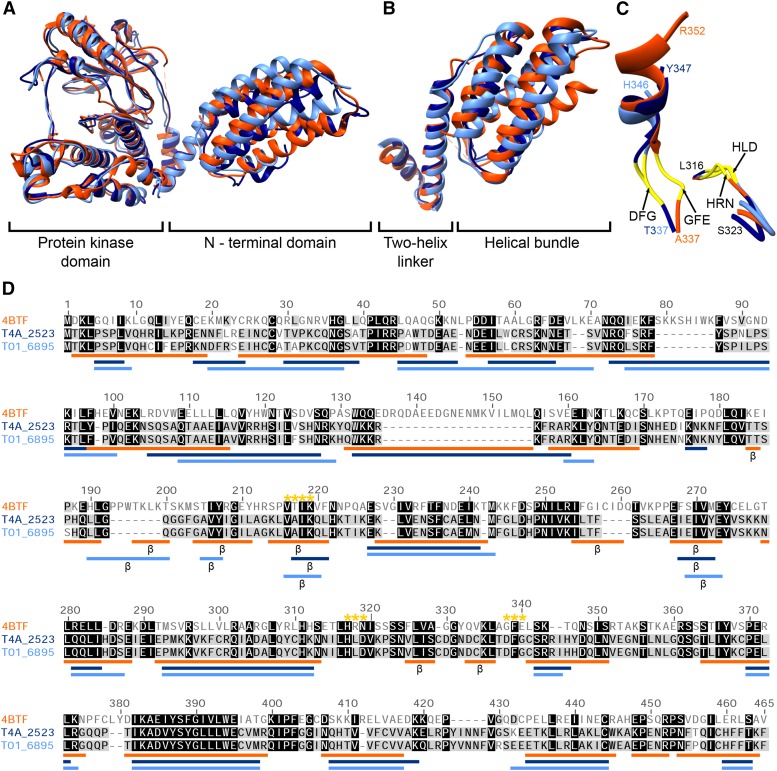
A novel, MOS-like protein kinase of Trichinella spiralis and T. pseudospiralis, which shares structural homology with the N-terminus of the murine mixed lineage kinase domain-like protein (MLKL). (A) Three-dimensional models of T. spiralis (T01_6895; light blue) and T. pseudospiralis (T4A_2523; dark blue) kinases superimposed on to the PDB (Protein Data Bank) structure of MLKL (4BTF; orange). (B) N-terminal domain comprised of a two-helix linker and a helical bundle. (C) Superimposed catalytic cleft of 4BTF, T01_6895, and T4A_2523. Motif regions are annotated and shown in yellow. Positions and amino acids of the last residues shown are indicated in the respective color for each model (black if the residues are the same in all three models). Numbering of residues is based on the multiple sequence alignment. (D) Multiple sequence alignment showing levels of similarity among residues for all three sequences (white to black; not conserved to conserved). Secondary structures based on three-dimensional modeling using the program I-TASSER for Trichinella models and based on the 4BTF crystal structure are depicted below the alignment; α helices are represented by lines in the same color as the respective model and beta sheets are also marked with a “β”. Motifs essential for kinase activity are marked with yellow stars.